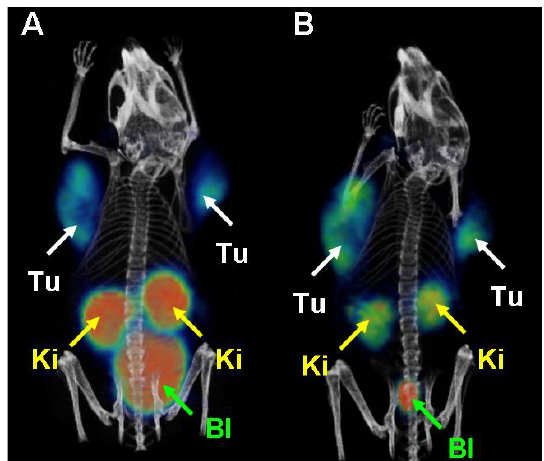
Figure 9. PET/CT images of KB tumor bearing mice. ( A ) Mouse injected with 68 Ga-EC0800 (~25 MBq) 1.5 h before scanning and ( B ) mouse which received pemetrexed (0.4 mg) prior to 68 Ga-EC0800 (~18 MBq). (Tu = KB tumor xenograft, Ki = kidney, Bl = urinary bladder). Reprinted (adapted) with permission from Müller et al . [6]. Copyright (2013) Bentham Science